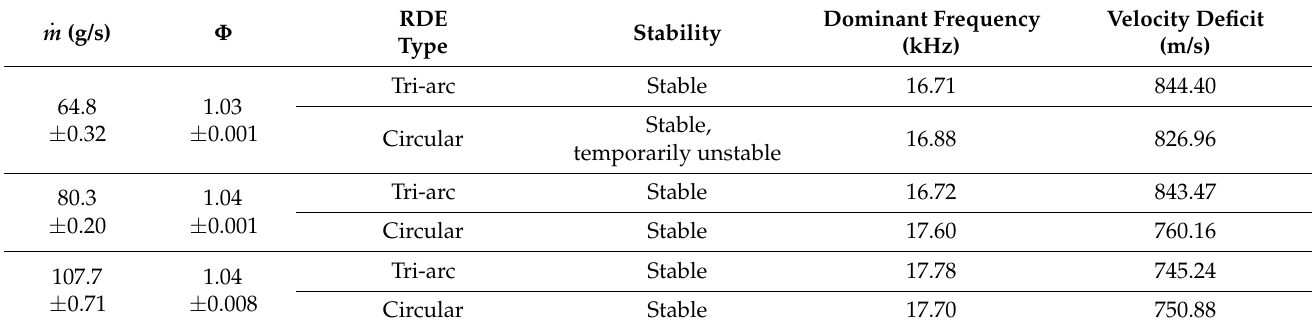
Table 2. Operation characteristics of tri-arc and circular RDEs for the other mass flow rate